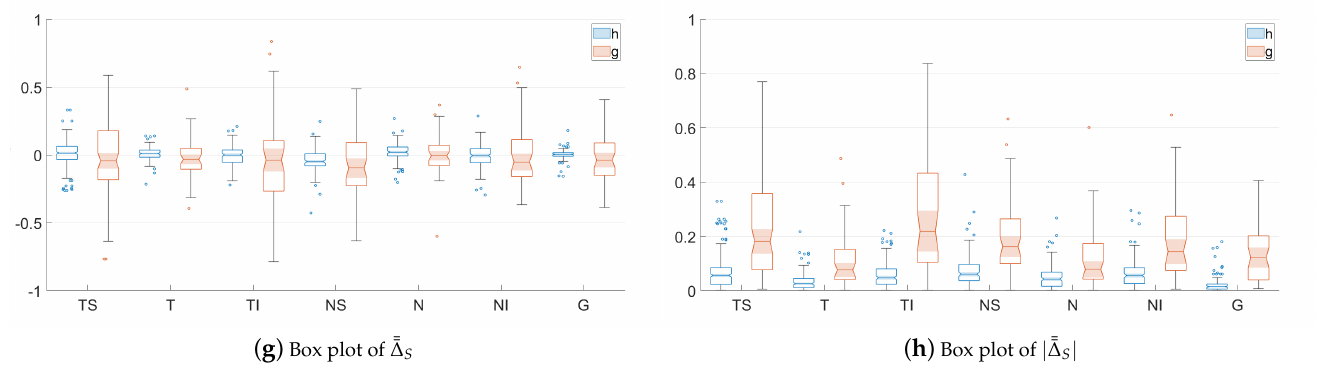
Figure 4. Notched box plots of the proposed RNFL thickness asymmetry metrics for the healthy (h) and glaucoma (g) subsets of patients, depicted for each eye sector (TS, T, TI, NS, N and NI) and for the overall global thickness value